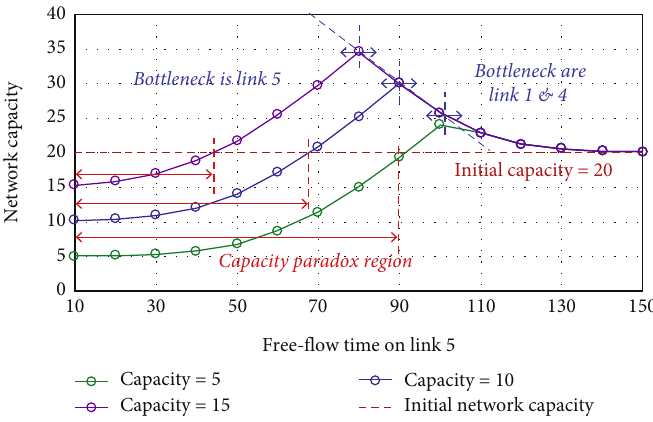
Figure 5: Network capacity with respect to the characteristics on the new added link.